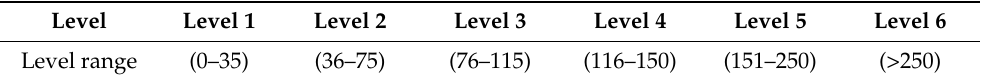
Table 4. Classification of PM2.5/PM10 concentration